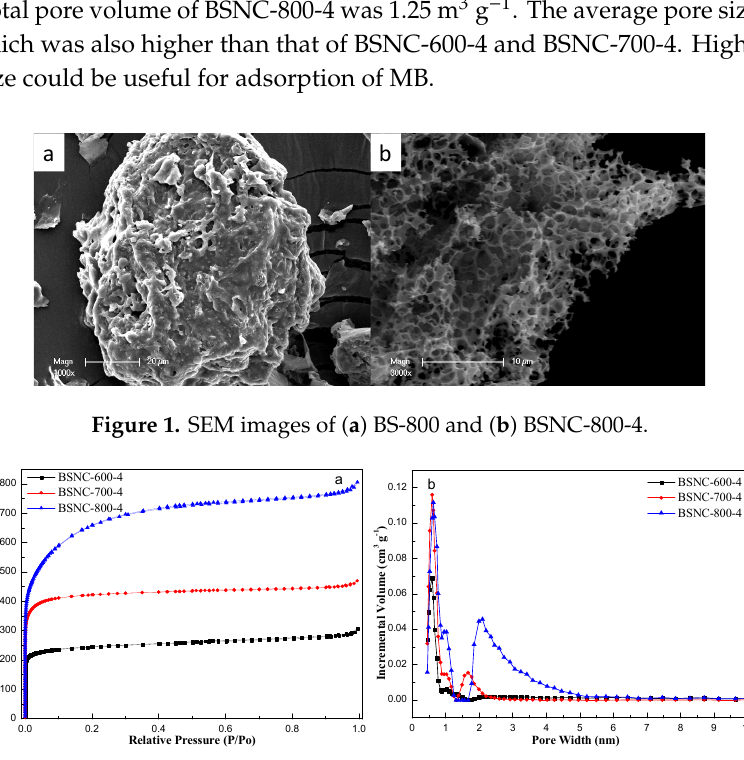
Figure 1. SEM images of ( a ) BS-800 and ( b ) BSNC-800-4.